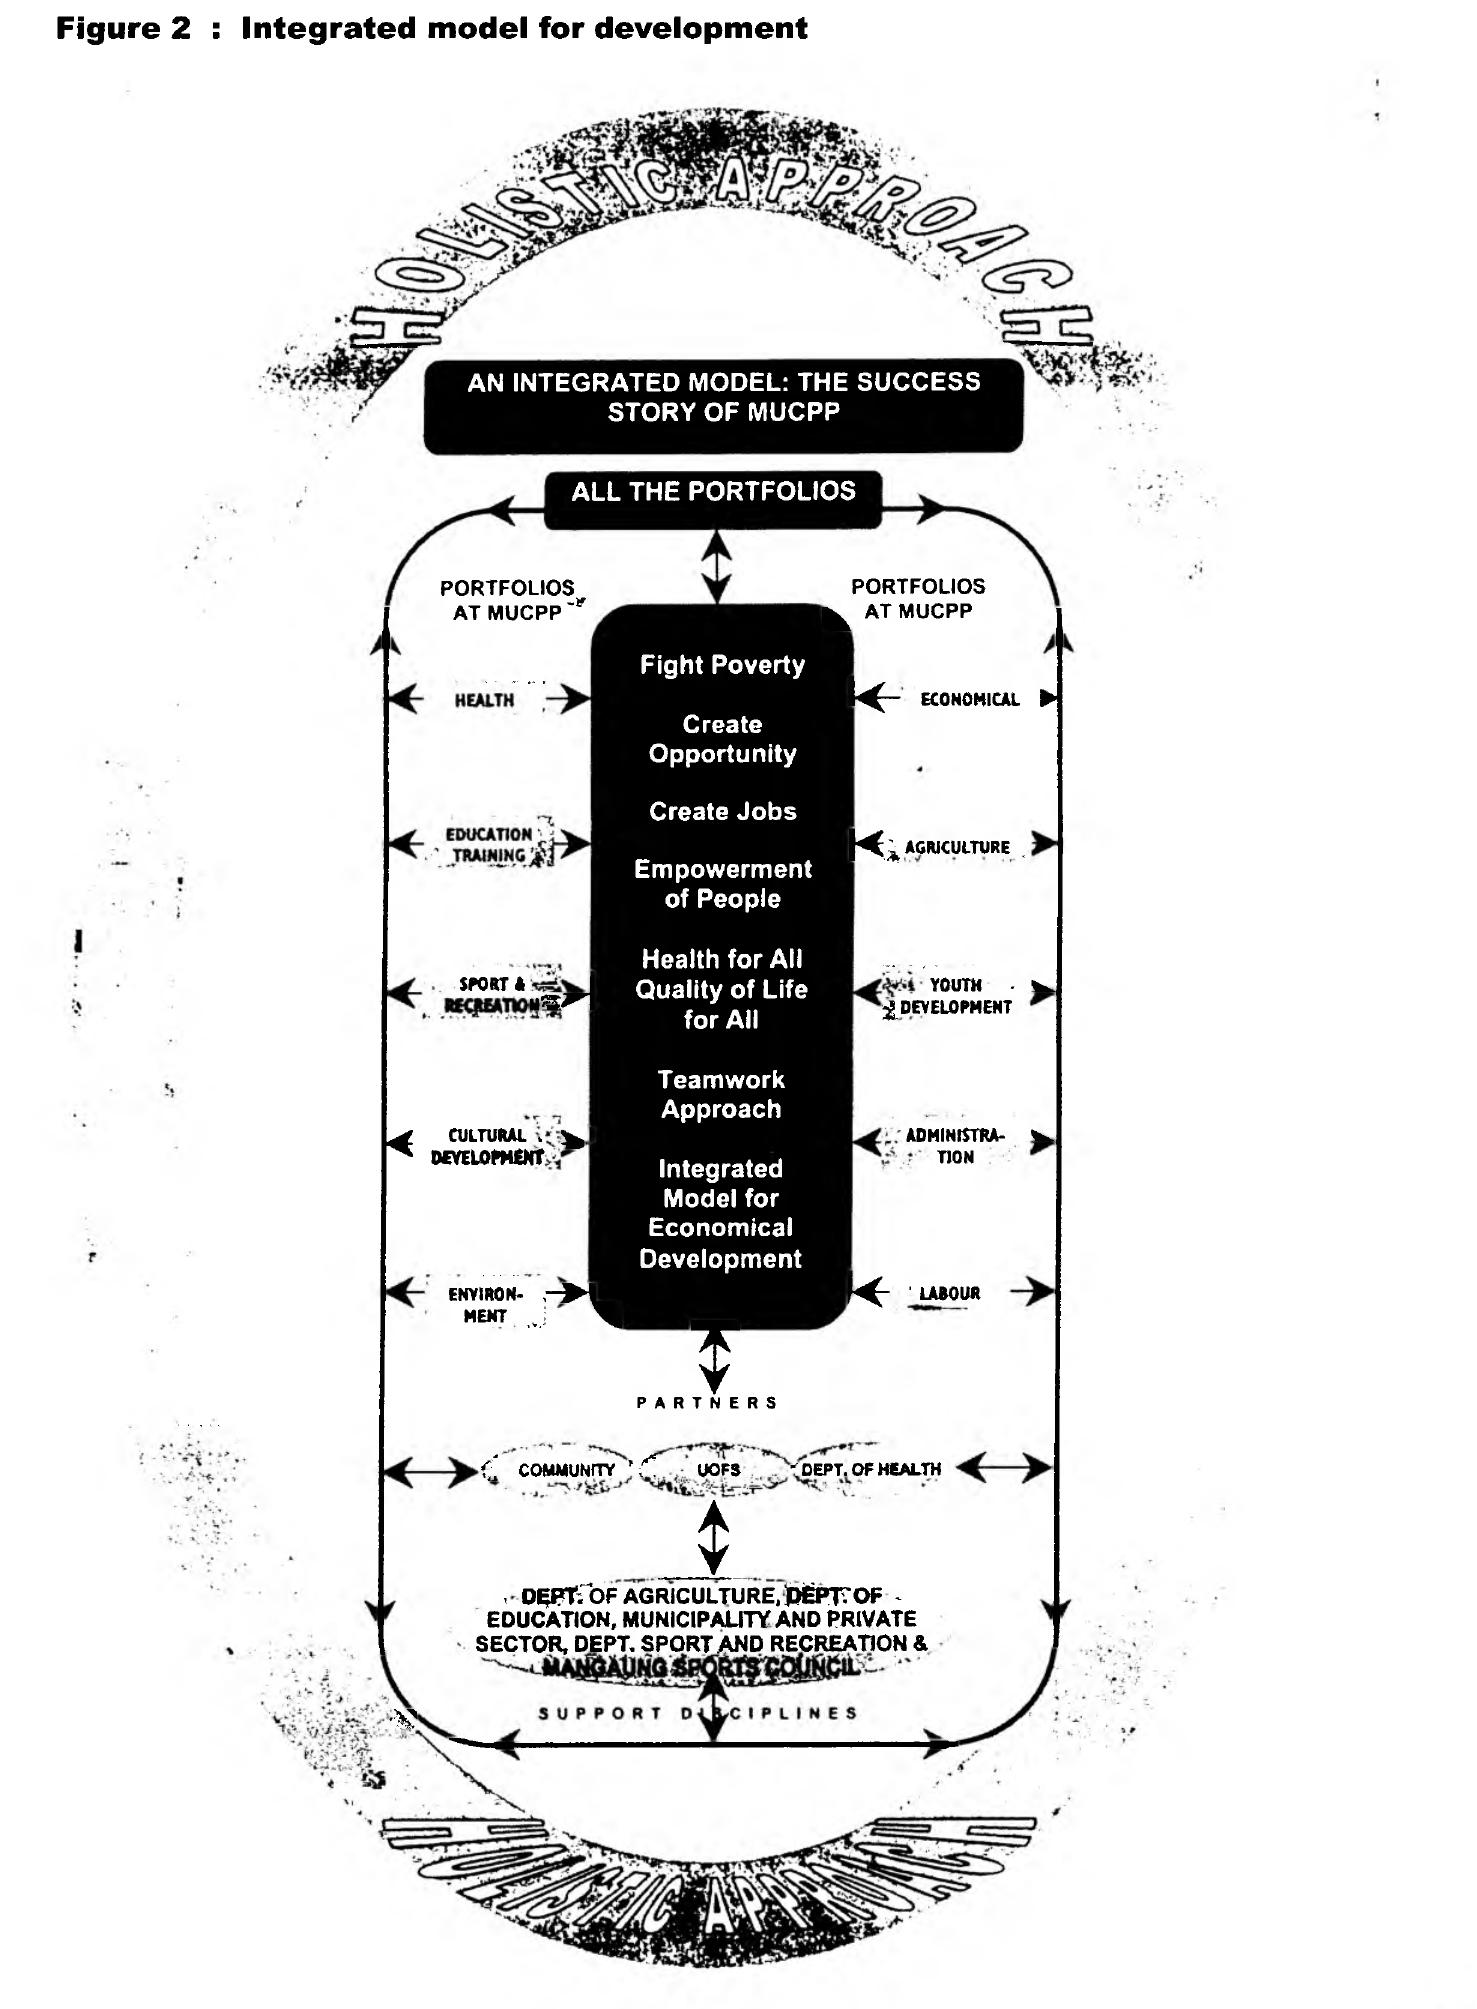
Figure 2 : Integrated model for developm